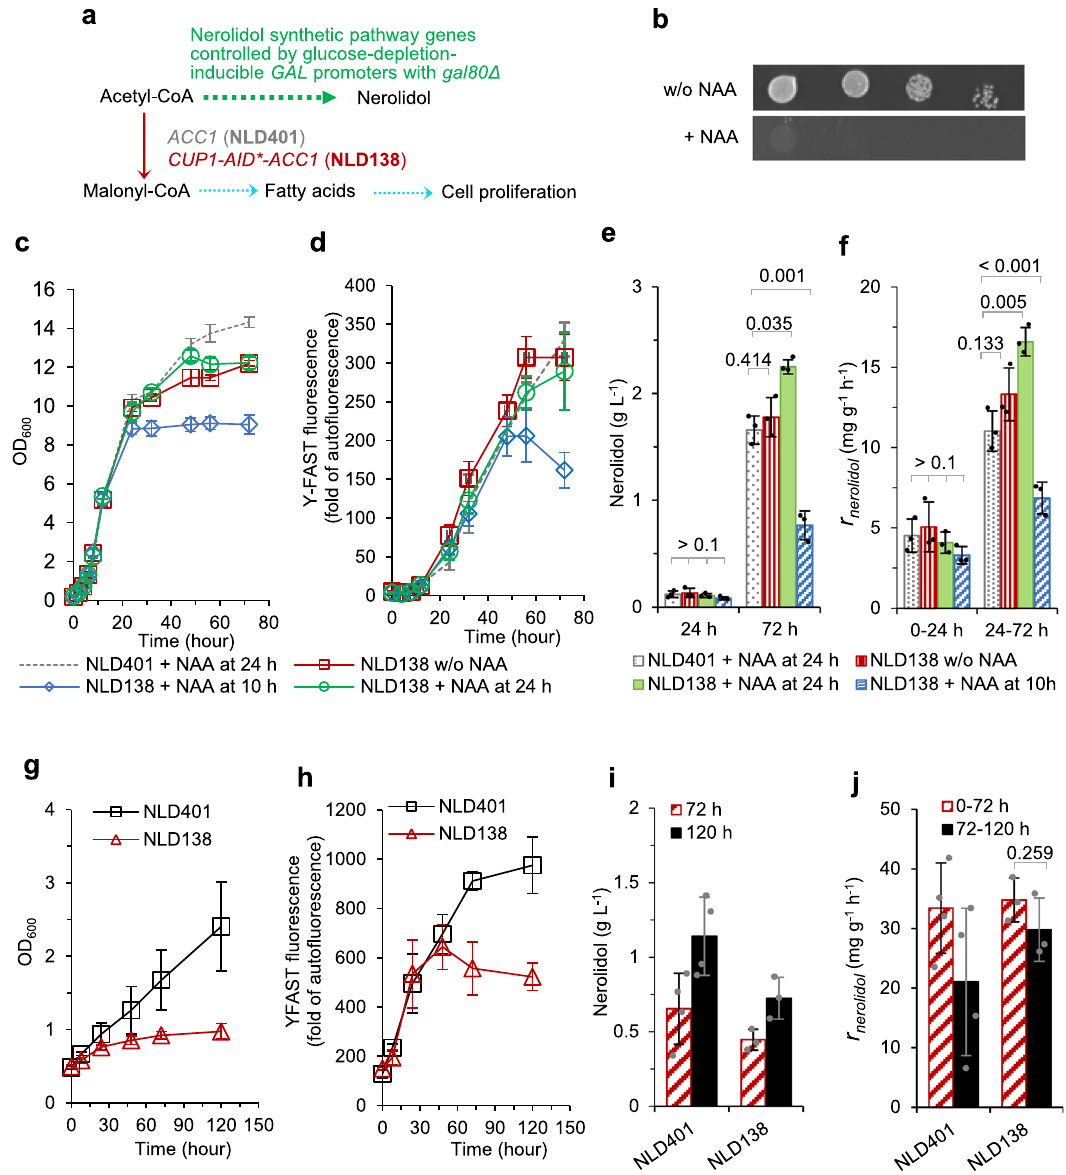
Fig. 4 Depleting malonyl-CoA synthase Acc1p arresting growth but not compromising terpene production. a Schematic of pathway engineering in strain NLD401 ( ACC1 wildtype) and strain NLD138 ( CUP1 -AID*- ACC1 ). b Growth of the background strain o138 ( CUP1 -AID*- ACC1 , GAL80 , without nerolidol synthetic module) on YNB-glucose agar with or without the addition of 1 mM 1-Naphthaleneacetic acid (NAA). The agar plate was incubated at 30 °C for 48 h. c – f Characterisation of strain NLD401 and strain NLD138 without NAA addition or with 1 mM NAA added at 10 h or 24 h in two-phase fl ask cultivation on 20 g L − 1 glucose. The growth, Y-FAST fl uorescence, and nerolidol production in strain NLD401 without NAA addition is available in Supplementary Fig. 2. g – j Characterisation of strain NLD401 and strain NLD138 with 1 mM NAA added at 0 h in two-phase fl ask cultivation on 2% (v/v) ethanol. Y-FAST was under the control of the GAL2 promoter. Y-FAST fl uorescence was measured in cells mixed with 20 μ M 4-hydroxy-3- methylbenzylidene rhodanine (HMBR). Y-FAST fl uorescence is expressed as fold-change of exponential-phase auto- fl uorescence of a reference strain GH4. Mean values ± standard deviations are shown ( N = 3 or 4 independent biological replicates). Two-tailed Welch ’ s t -test was used for comparing two groups, and p values are shown above the bars. Source data in c – j are provided as a Source Data fi